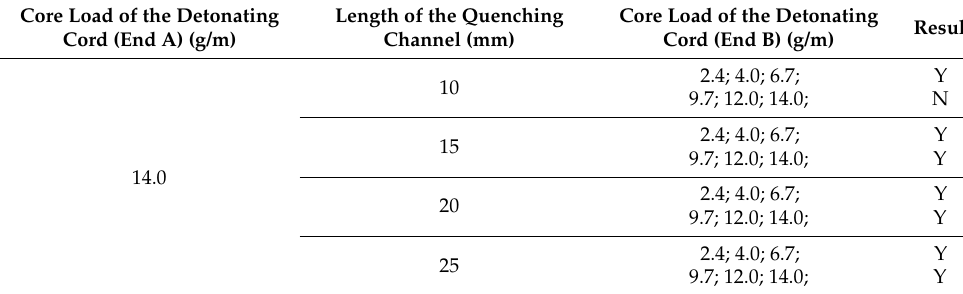
Table 4. Explosion-proof results using different design parameters. Core Load of the Detonating